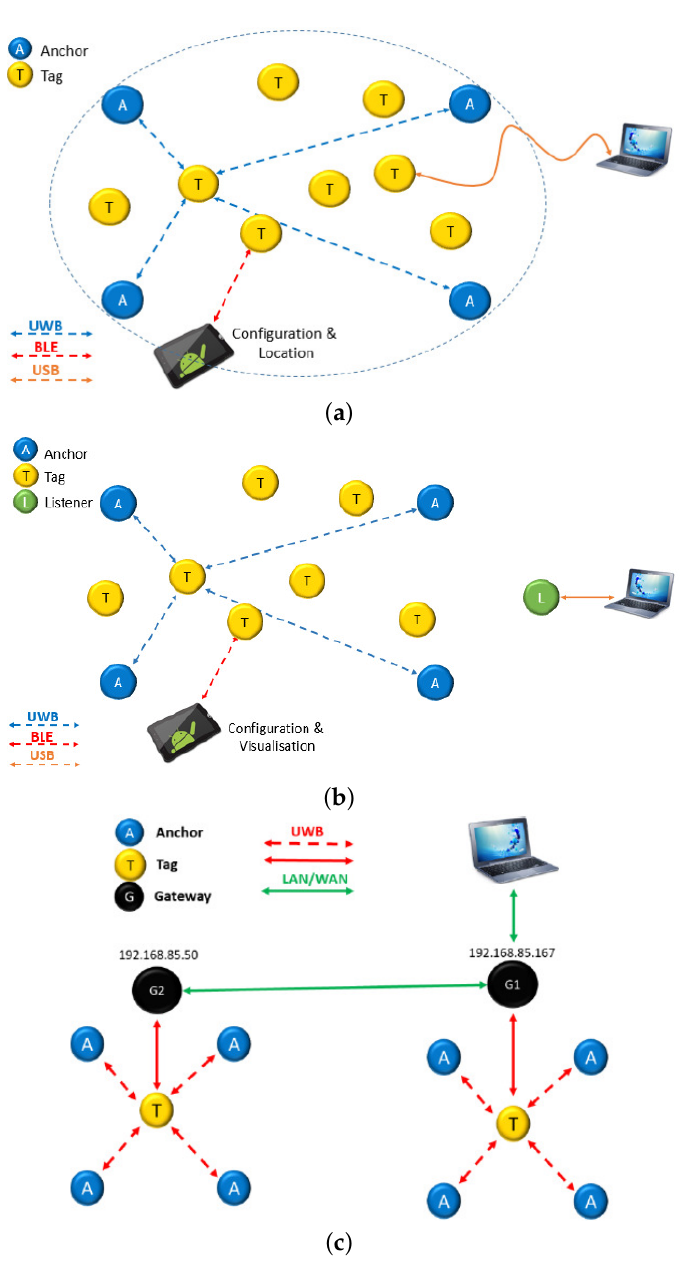
Figure 2. Different configurations of the DWM1001DEV modules to create a location network, and ways of monitoring: ( a ) normal mode with connection to individual tags (access to position of that tag and four ranges); ( b ) extended mode with listener to access positions of all tags in the network (not ranges); ( c ) extended mode with gateways to increase scalability of the deployment and also get access to positions of all the tags in the network (not ranges)